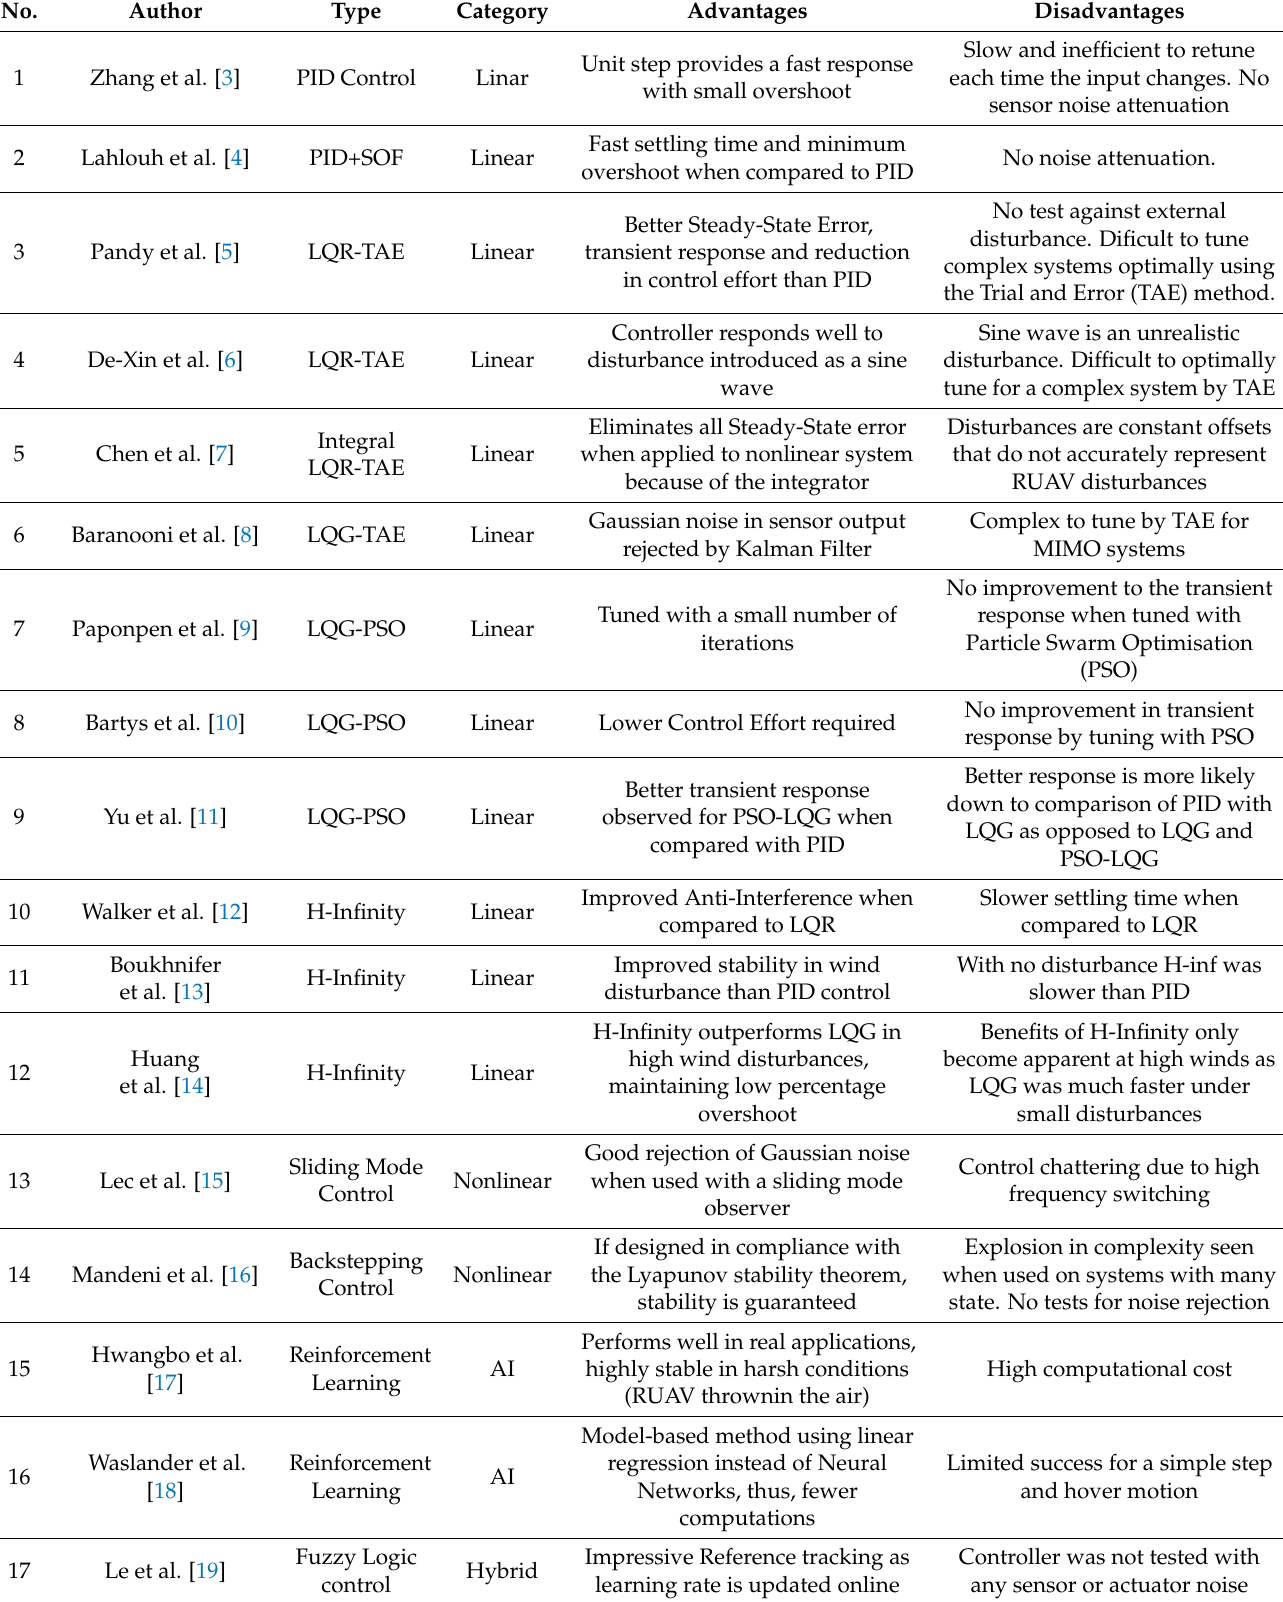
Table 1. State of the art Control strategies for stability of